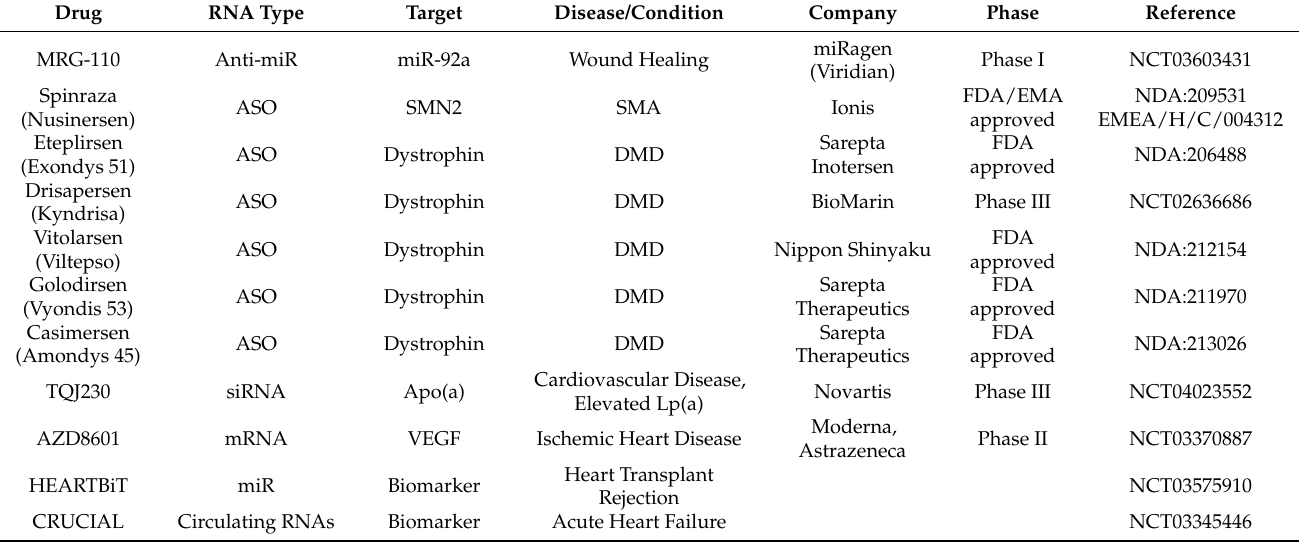
Table 1. RNA-based drugs and biomarkers for cardiac and skeletal